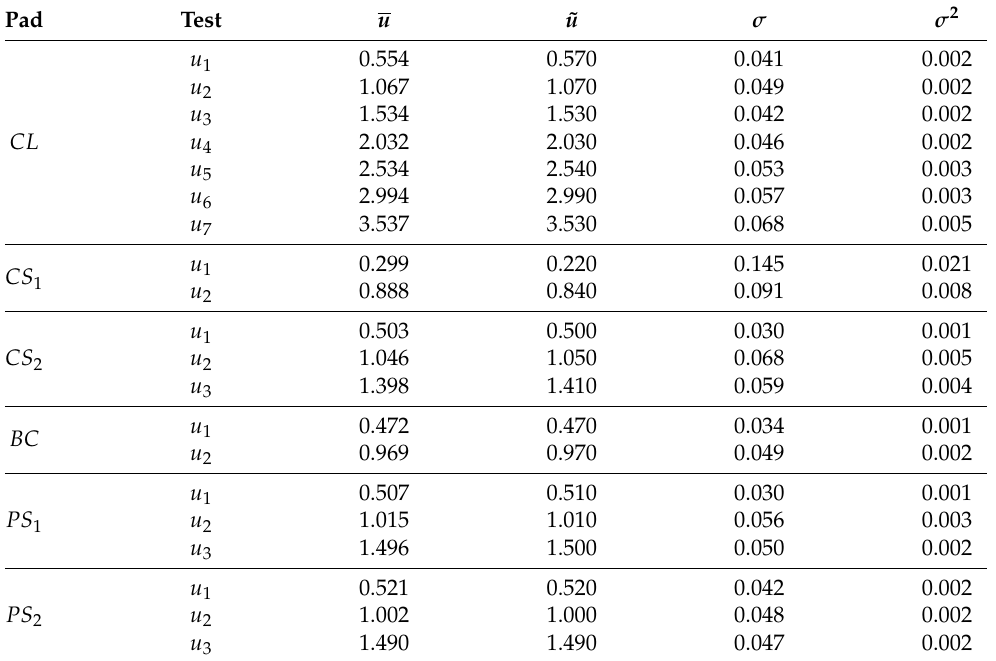
Table 7. Statistics of inlet air velocity for the wind tunnel tests. u is the mean [m s − 1 ], ˜ u is the median [m s − 1 ], σ is the standard deviation [m s − 1 ] and σ 2 is the variance [m 2 s − 2